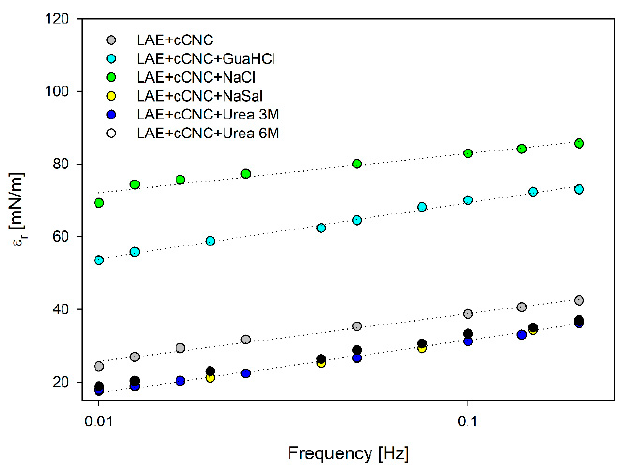
Figure 6. The frequency dependence of the dilational elasticity modulus in LAE-cCNC dispersions with the addition of 5 mmol/L electrolytes (guanidine hydrochloride, sodium chloride, sodium salicylate) and with urea at concentrations as